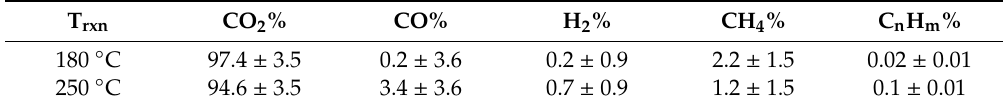
Table 8. Gas composition during HC